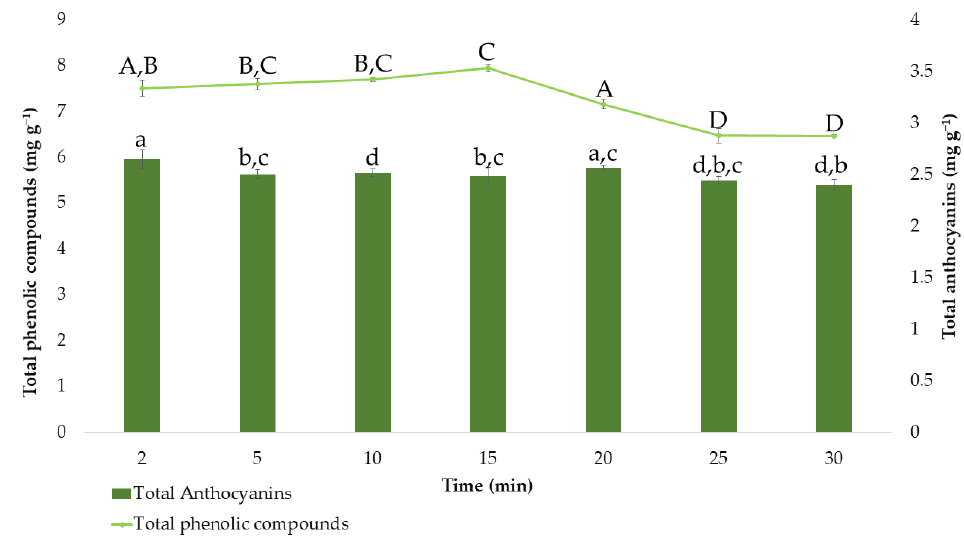
Figure 5. Amount of total phenolic compounds and total anthocyanins (means ± SD) extracted at different times. Different letters mean statistically significant differences according to Tukey’s test at the 95% level of significance.